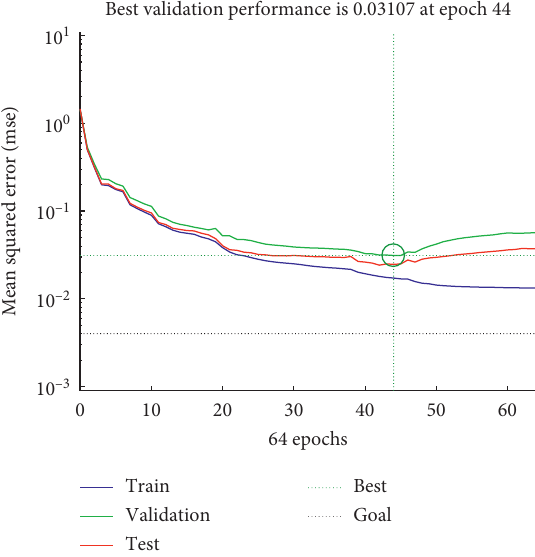
Figure 5: The BP neural network learning